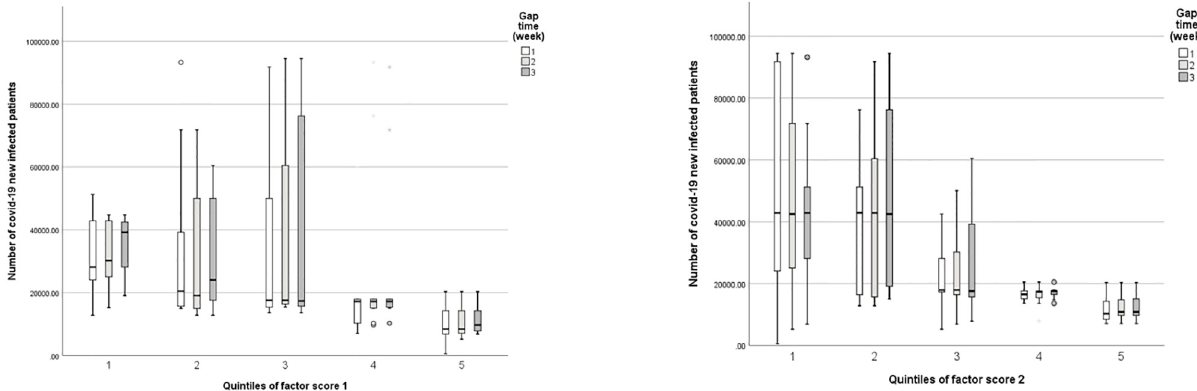
Fig 3. Box plot of quintiles in factor score 1 and factor score 2 based on time.